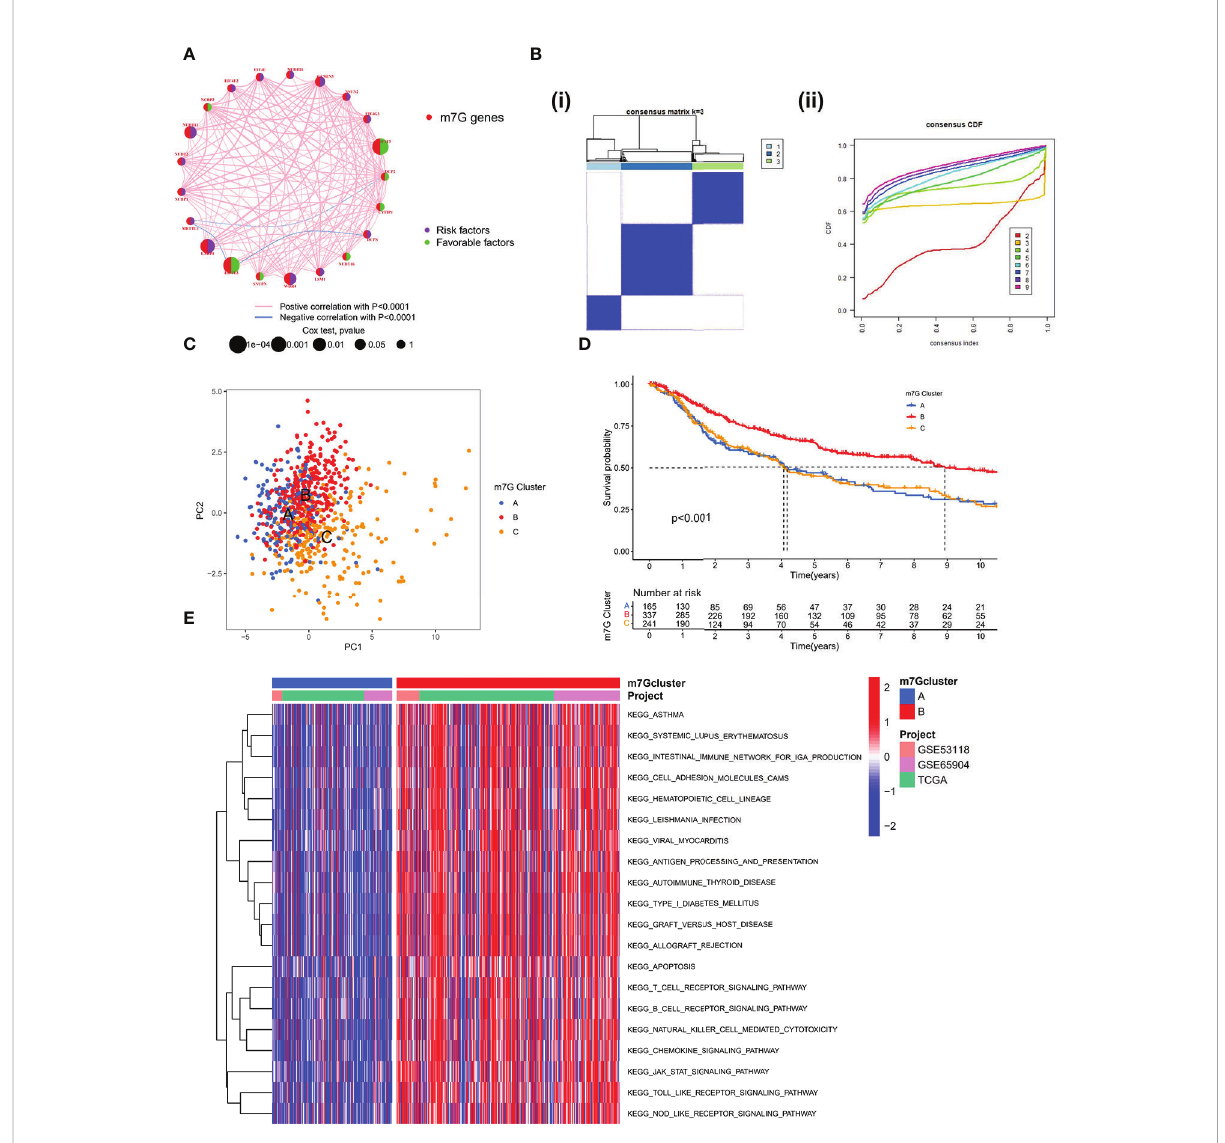
FIGURE 2 Patterns of m7G methylation modi fi cation. (A) Interaction network of the 21 m7G genes. In meta-SKCM cohort(GSE53118, GSE65904, TCGA). Purple dots represent risk factors and green dots represent favorable factors. (B) 743 SKCM patients were divided into 3 groups using Consensus clustering matrix. (C) Principal component analysis of m7G modi fi cation pattern. (D) Kaplan – Meier survival analysis of OS for different m7G clusters in meta-SKCM cohort(p < 0.001). (E) GSVA enrichment analysis between m7G cluster A and